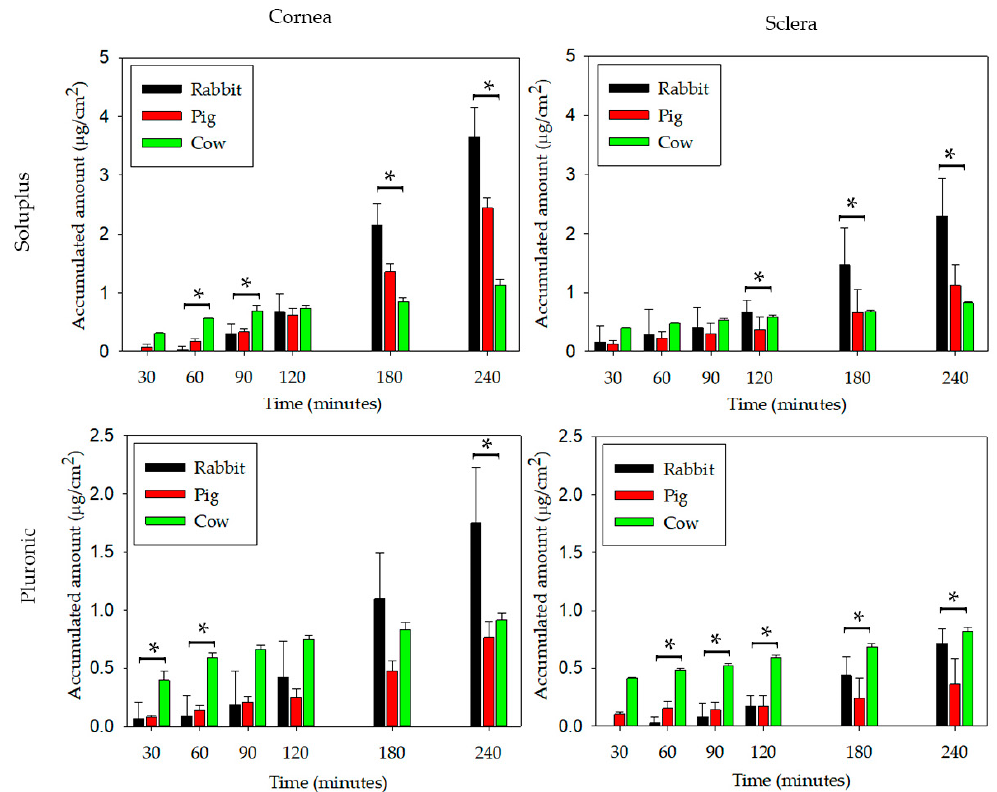
Figure 5. Accumulated amount of PG permeated through rabbit, porcine and bovine cornea, and sclera and measured in the receptor chamber as a function of time. PG was formulated in Soluplus and Pluronic micelles, total copolymer concentration was 20% w / w in all cases ( n = 4). * Significant differences were found between the three species ( p < 0.05).